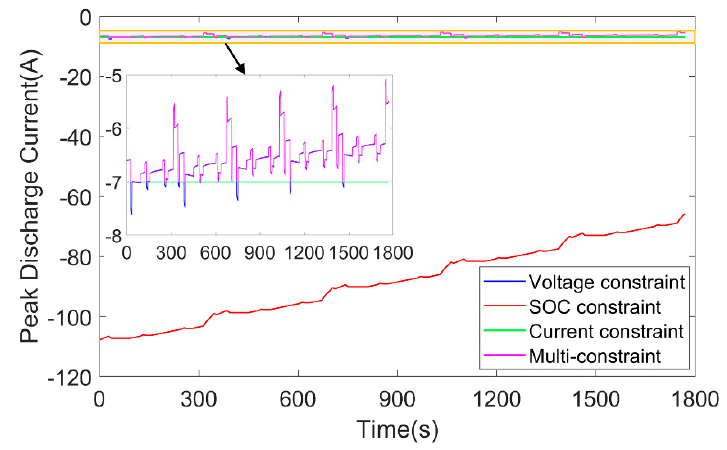
Figure 25. Multi-constrained battery discharge peak current curve.